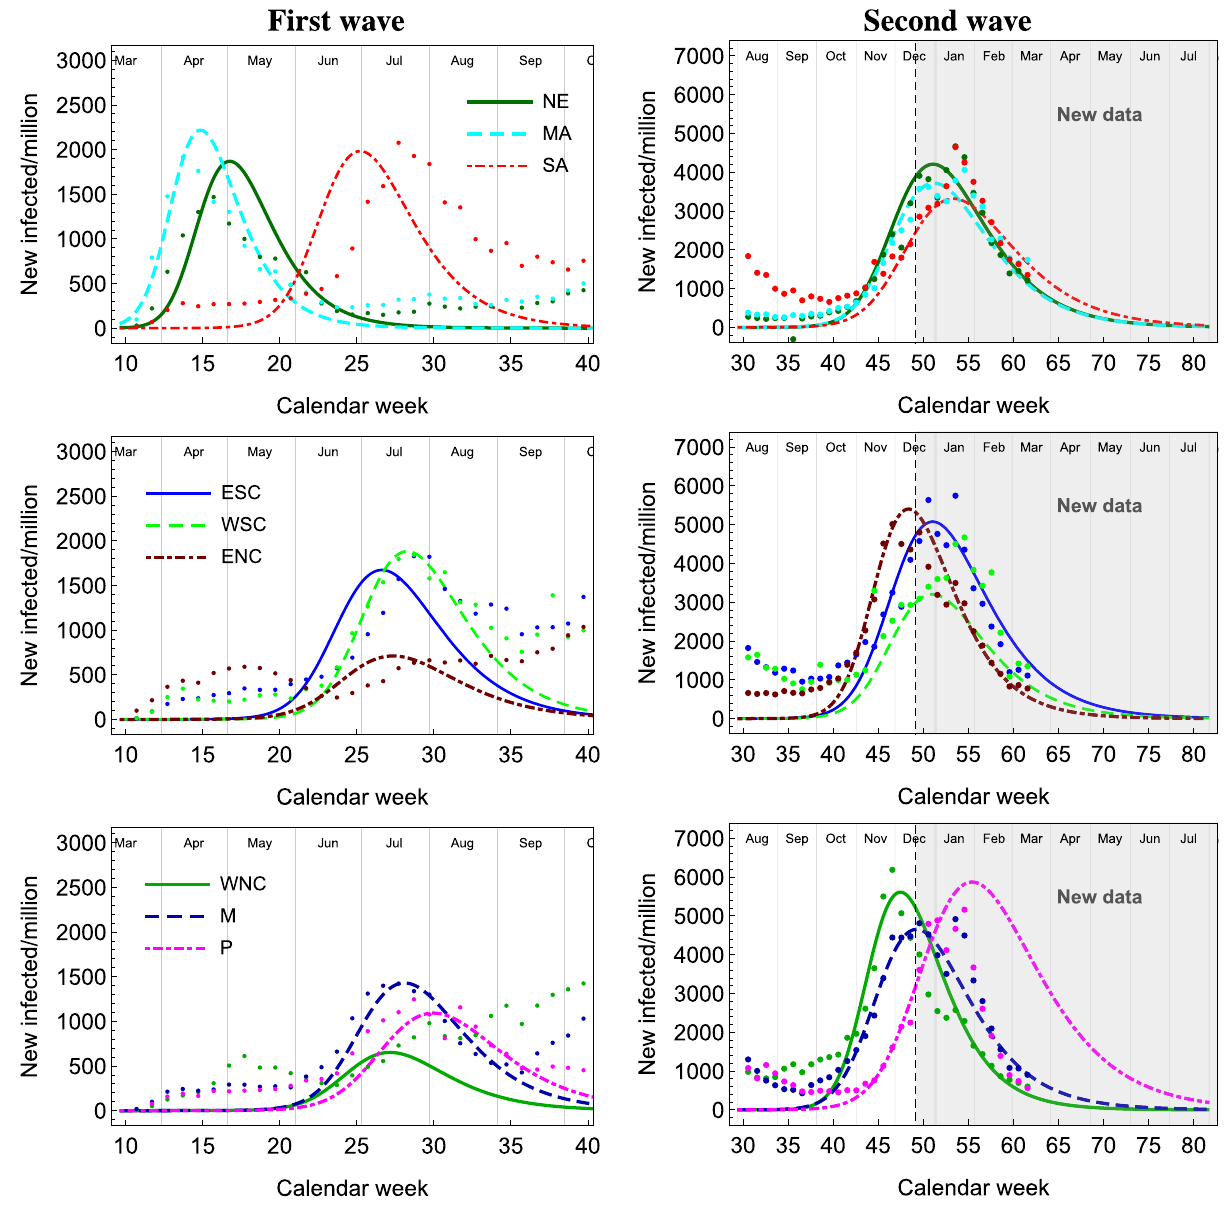
Figure 5. Simulation of the spread of the first wave (left plots) and the second wave (right plots) using flight-data-derived kappa matrix. For the first wave, MA is used as a seed region, while for the second wave a combination of the first waves among divisions acts as the seed region (Region-X). The vertical dashed lines in the right column plots mark the date when the simulation was done. The data points in the grayed region where not used to tune the eRG